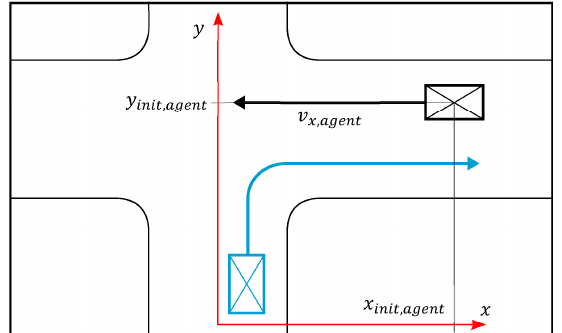
Figure 6. Investigated right-turn maneuver. Blue box and line: ego vehicle with reference trajectory. Black box and line: traffic agent with straight trajectory.